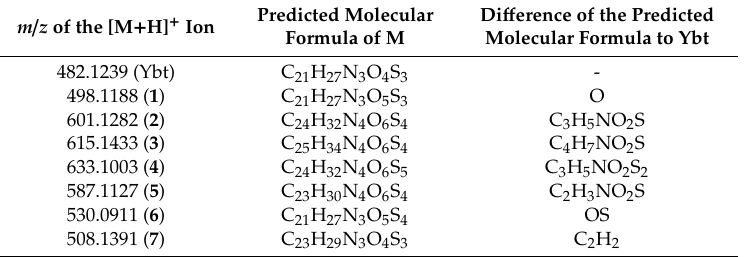
Table 3. Predicted molecular formulas of the novel derivatives based on mass spectrometric fragmentation experiments and the di ff erence of these molecular formulas compared to Ybt.